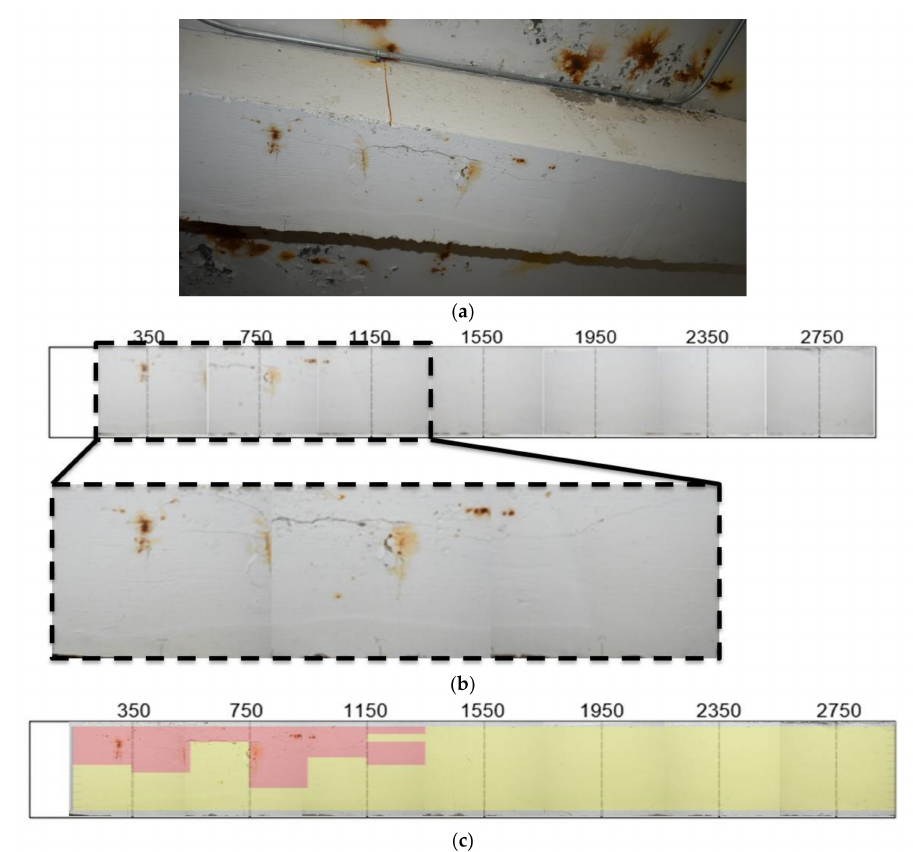
Figure 8. Condition of beam: ( a ) comprehensive view; ( b ) compilation of test area images for analysis; and ( c ) expected results from